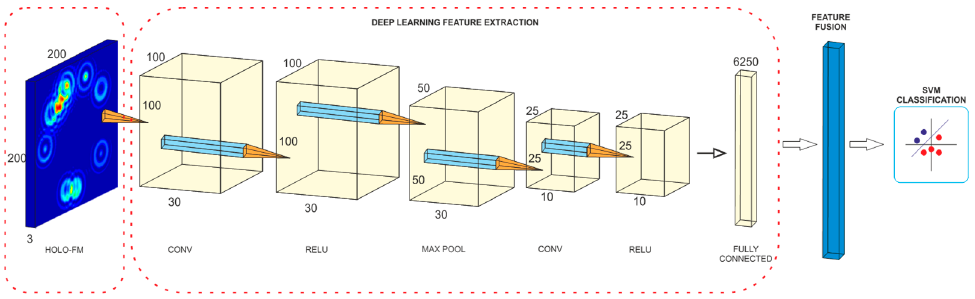
Figure 7. Flow chart of feature extraction, fusion, and classification.